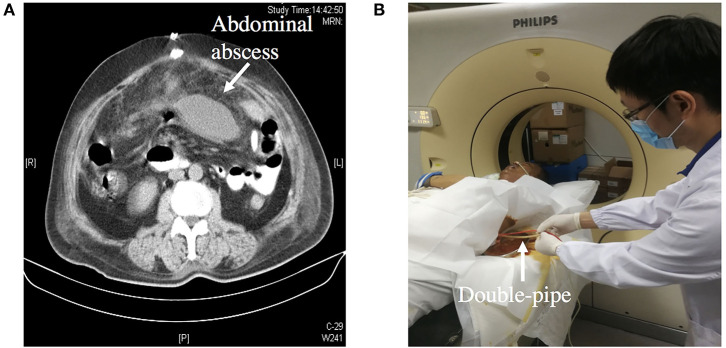
(A) Showing an abdominal abscess due to ECF. (B) Showing CT-guided double-pipe placement for continuous irrigation and drainage of the abscess.